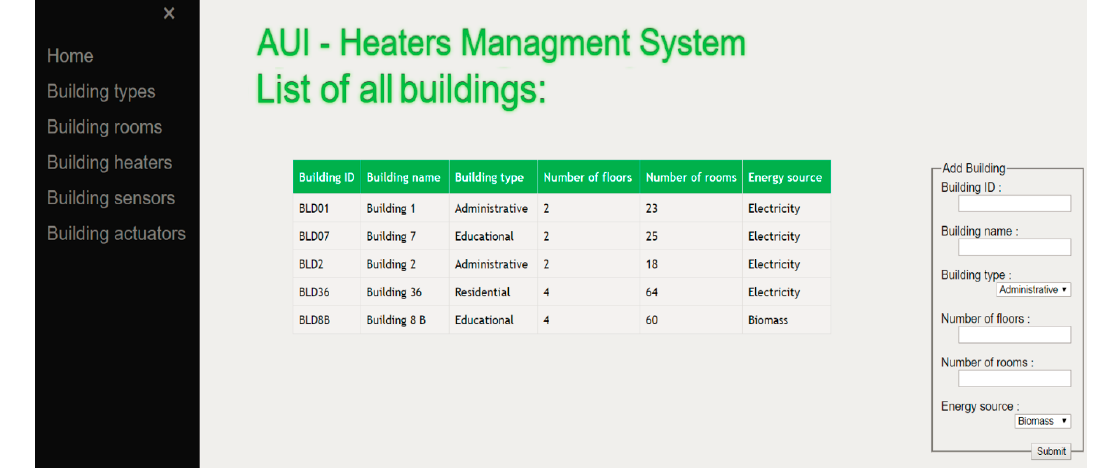
Figure A2. List of buildings in the EMS.